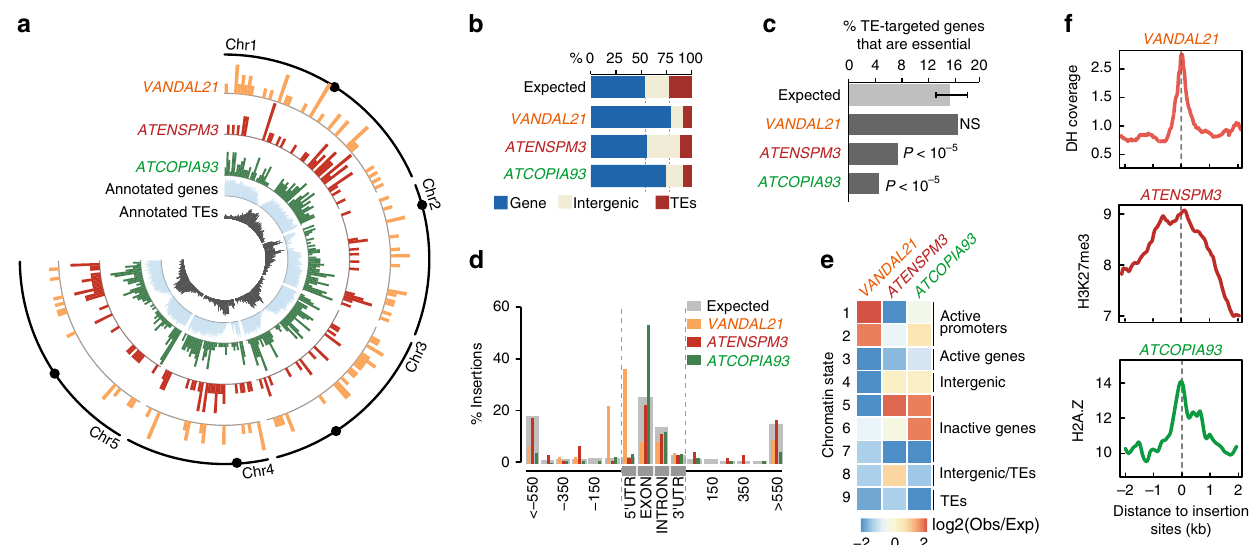
Fig. 3 TEs exhibit strong and diverse chromatin-associated insertion biases towards genes. a Circos representation of private TE insertions detected for VANDAL21 , ATENSPM3 , and ATCOPIA93 within wild-type intervals. Centromere positions are indicated by black dots. b Fraction of TE insertions in genes, TEs and intergenic regions. c Fraction of essential genes among genes targeted by VANDAL21 , ATENSPM3 or ATCOPIA93 in the epiRILs. Statistical signi fi cance for each comparison was obtained using the Chi-square test. d Metagene analysis showing the distribution of new insertions. e Relative abundance of insertion sites in relation to the nine chromatin states de fi ned in A. thaliana . f Levels of DNAse hypersensitivity (DH; top panel), H3K7me3 (middle panel), and H2A.Z (bottom panel) around VANDAL21 , ATENSPM3 , and ATCOPIA93 insertion sites, respectively. Source data are provided as a Source Data fi le